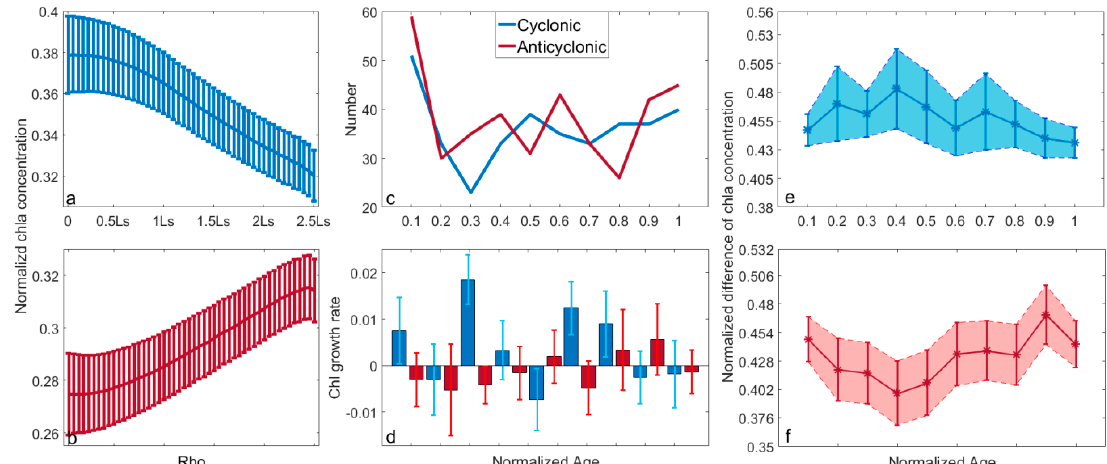
Figure 18. Averaged normalized Chl as a function of the eddy normalized radius for CEs ( a ) and AEs ( b ). ( c ) The number of vortices exhibiting high values of Chl in different eddy life stages. ( d ) Change rate of normalized Chl concentration in different life stages of eddy; changes in normalized Chl at different life stages for ( e ) CE and ( f ) AE. The error bar is defined as standard deviation.